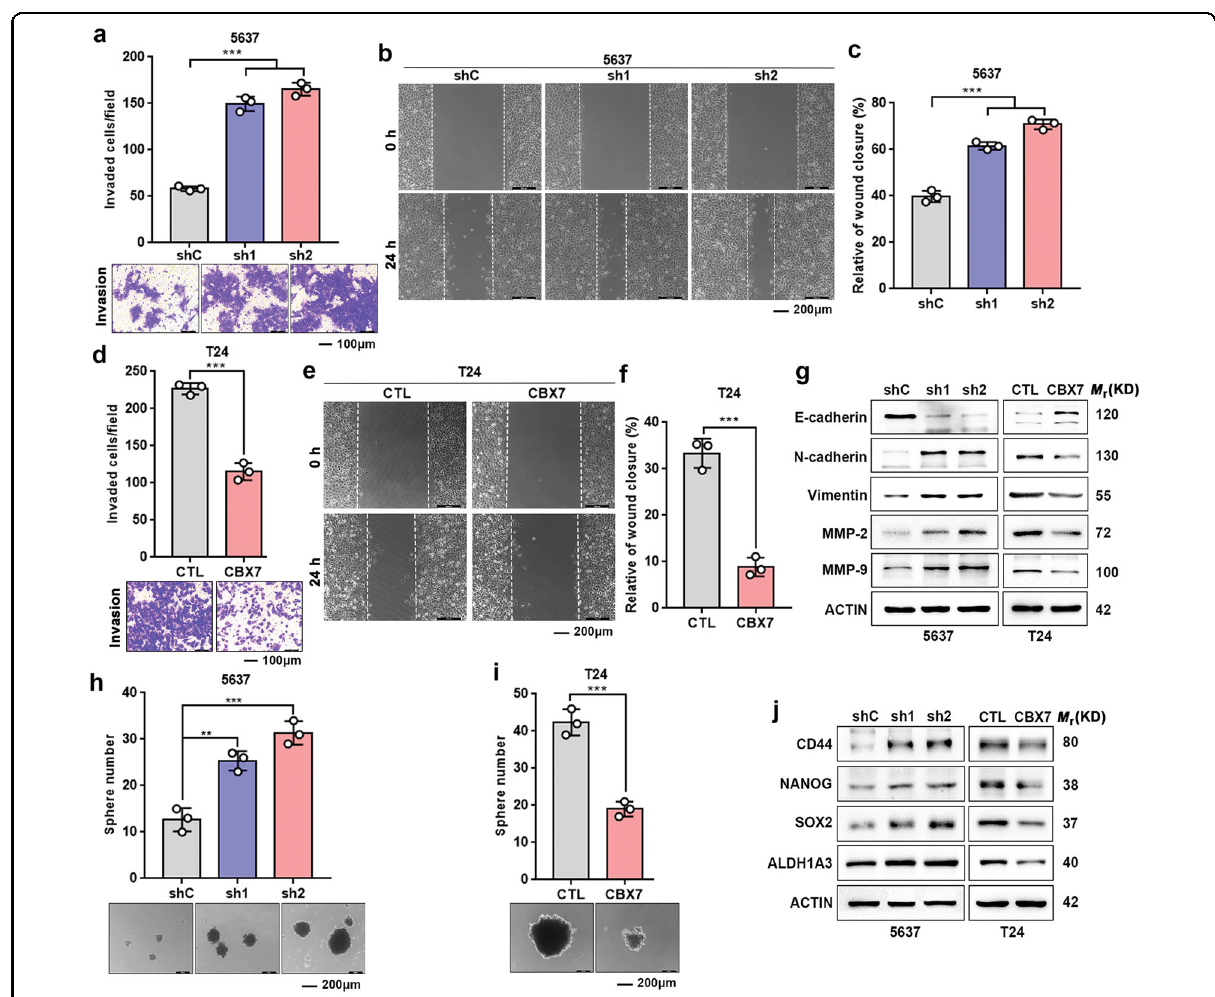
Fig. 3 CBX7 suppresses UBC cells invasion, migration, and stemness. a – c Effects of CBX7 knockdown on cell invasion ( a ) and migration ( b , c ). d – f Effects of CBX7 overexpression on cell invasion and migration. g Epithelial and mesenchymal transition markers, and matrix metalloproteinases were detected by western blotting. h , i Effects of CBX7 on the size and number of spheres. j The levels of core stem cell genes were detected by western blotting. Scale bar, 100 μ m ( a , d ); 200 μ m ( b , e , h , i ). Data are presented as means ± SD from three independent replicates. ** p < 0.01, *** p <